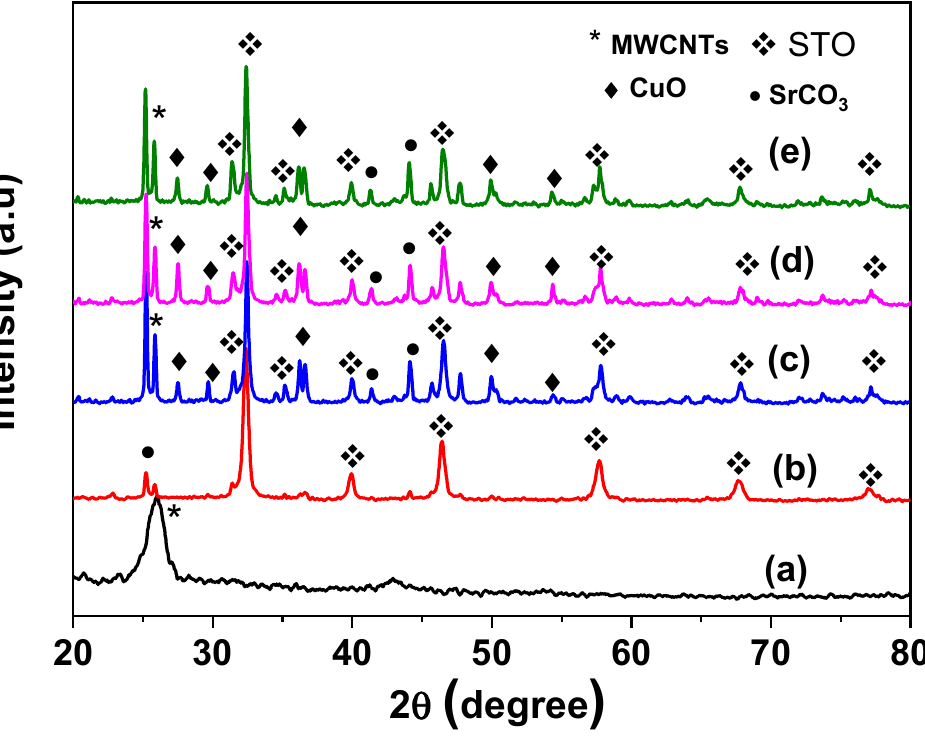
Figure 1. XRD patterns of MWCNTs ( a ), STO ( b ), 1% CuO/STO/MWCNTs ( c ), 3% CuO/STO/MWCNTs ( d ), and 5% CuO/STO/MWCNTs ( e ). The elemental compositions of the samples were explored through EDX analysis.